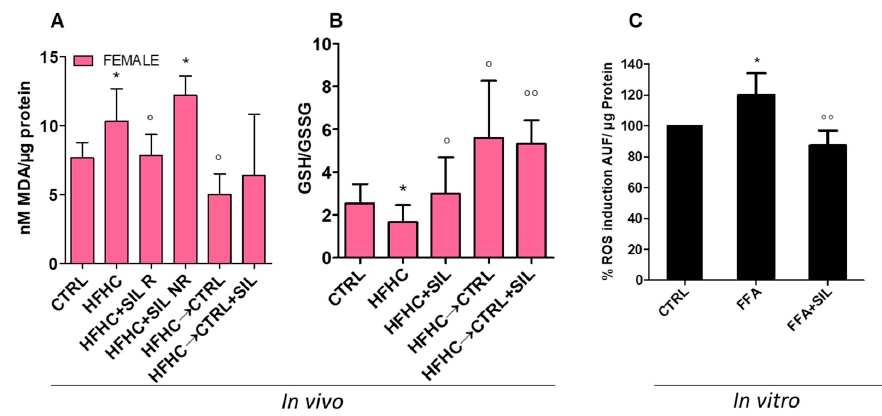
Figure 5. Assessment of antioxidant properties of silymarin formulation. The redox state was calculated in vivo as the amount of lipoperoxides (MDA) ( A ) and the cellular antioxidant properties measured as the glutathione ratio (GSH/GSSG) ( B ). Whereas, in vitro were measured the total amount of reactive oxygen species ( C ). * p < 0.05 vs. CTRL; p < 0.05 vs. HFHC/FFA; p < 0.01 vs. HFHC/FFA